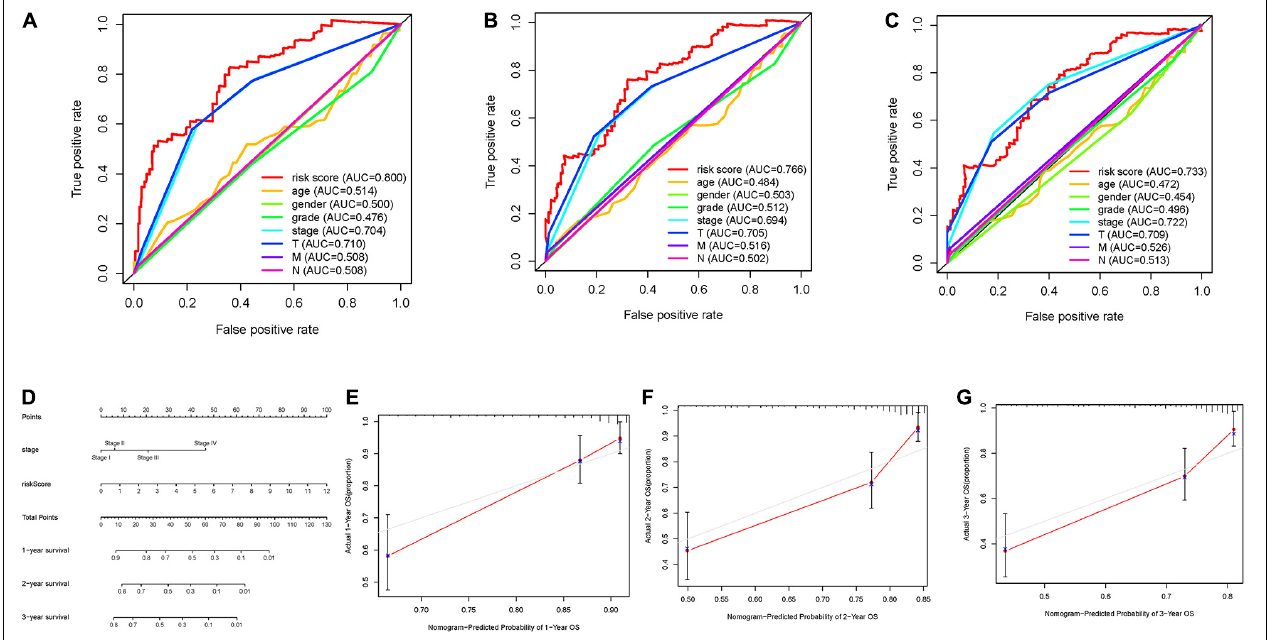
FIGURE 6 | Validation of prognostic efficiency of risk signature. (A–C) AUCs of the risk scores for predicting 1–, 2–, and 3-year OS time with other clinical characteristics. (D) Nomogram was assembled by stage and risk signature for predicting survival of HCC patients. (E) One-year nomogram calibration curves. (F) Two-year nomogram calibration curves. (G) Three-year nomogram calibration curves.